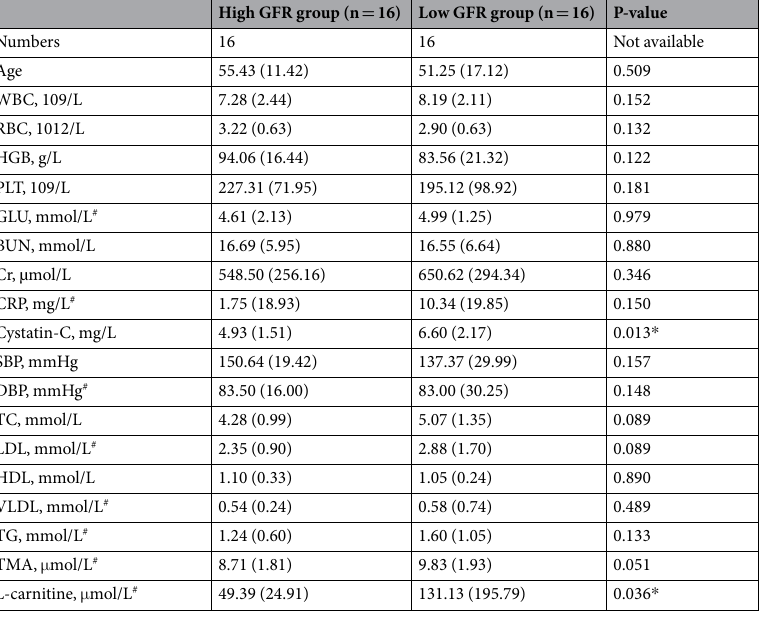
Table 2. Characteristics of the high GFR group and the low GFR group. Data represent the mean (standard deviation), and the data # represent the median (interquartile range). For all records, the P values represent the results of the Mann-Whitney U test. WBC, white blood cell count; RBC, red blood cell; HGB, haemoglobin; PLT, platelet; GLU, glucose; BUN, blood urea nitrogen; Cr, creatinine; CRP, c-reactive protein; SBP, systolic blood pressure; DBP, diastolic blood pressure; TC, total cholesterol; LDL, low-density lipoprotein; HDL, high- density lipoprotein; VLDL, very low-density lipoprotein; TG, triglycerides; TMA, trimethylamine. * P < 0.05; ** P < 0.01; *** P <